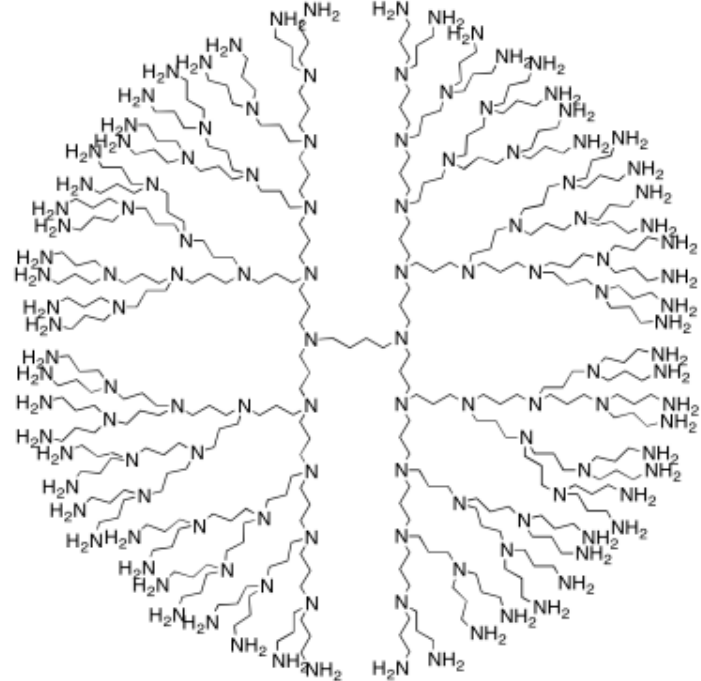
Figure 2. NS 2 [ p ] polypropylenimine octaamin Figure 2. 𝑁𝑆 (cid:2870) [𝑝] polypropylenimine octaamin dendrimers. Figure 2. 𝑁𝑆 (cid:2870) [𝑝] polypropylenimine octaamin dendrimers.